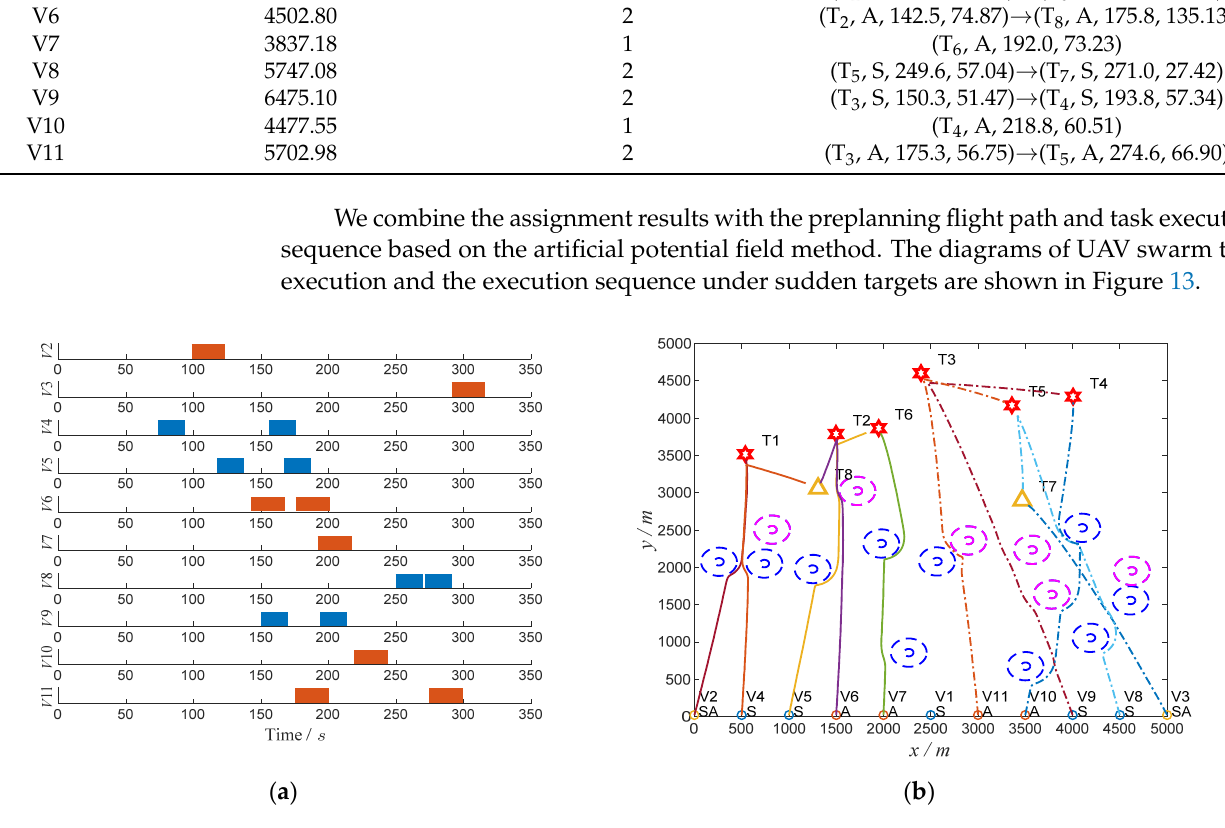
Table 10. Task assignment under the circumstance of UAV breakdown. Subtask